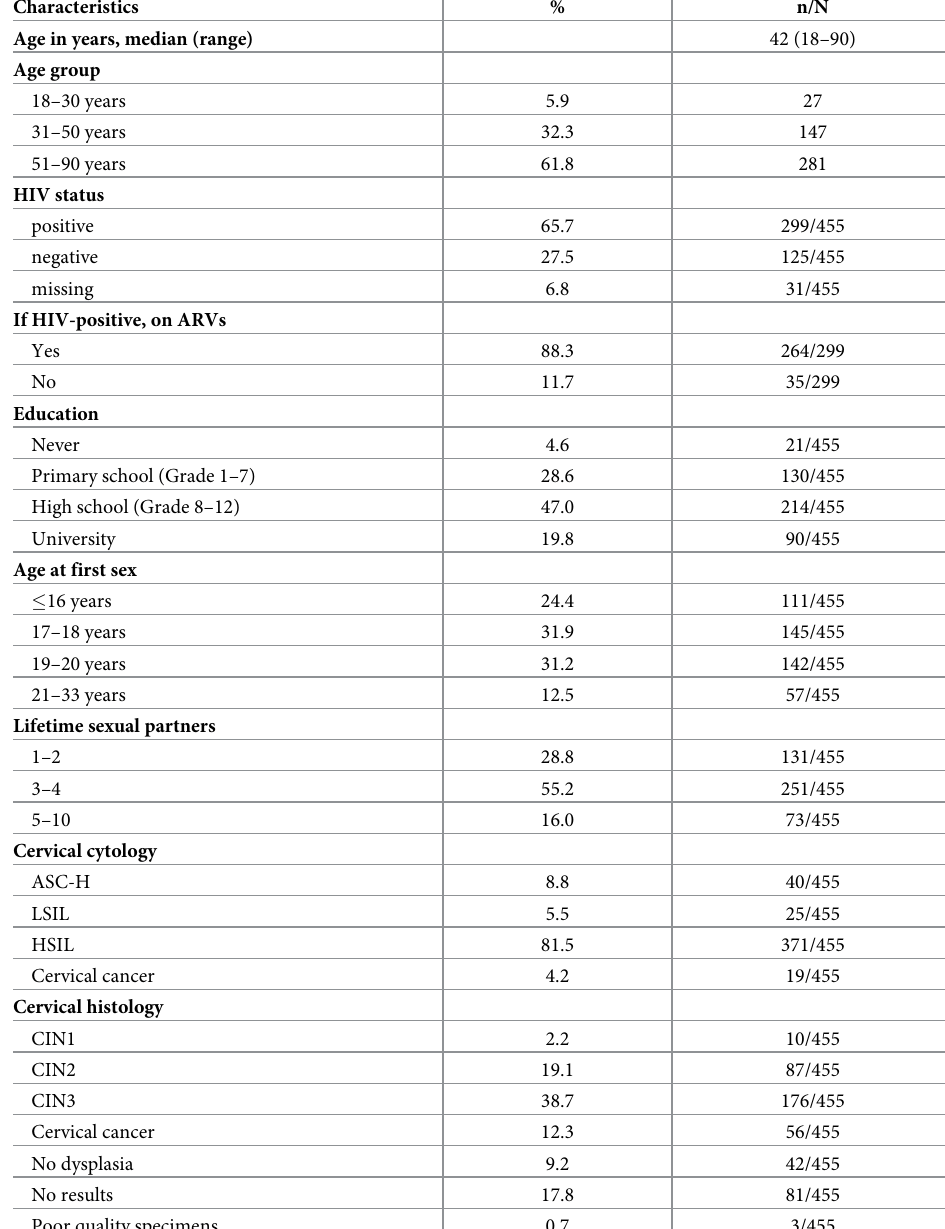
Table 1. Demographic and behavioural characteristics of study participants.